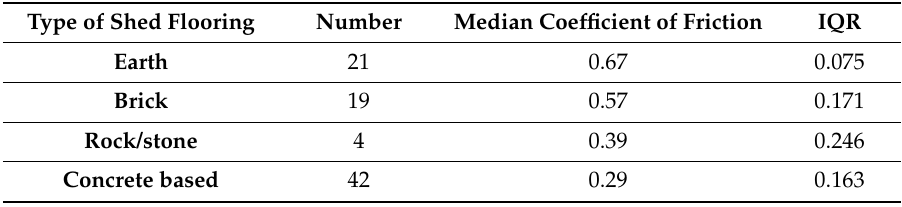
Table 3. Shed coefficients of flooring for four types of flooring in cow shelters ( n =